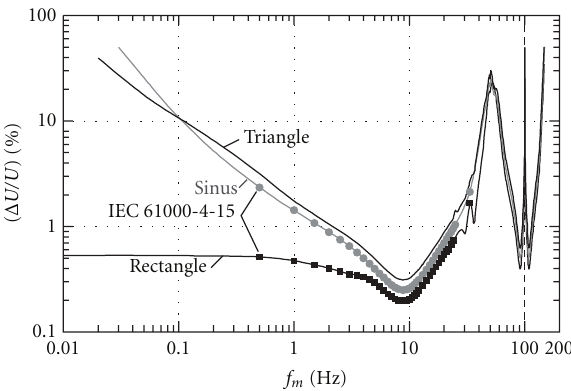
Figure 4: P st = f ( f m ) graph for sinusoidal, triangular, and rec- tangular modulating signal u mod ( t ) (signal u IN ( t ) described with (2)) with constant modulation depth ( Δ U/U ) = 0 . 2503%.